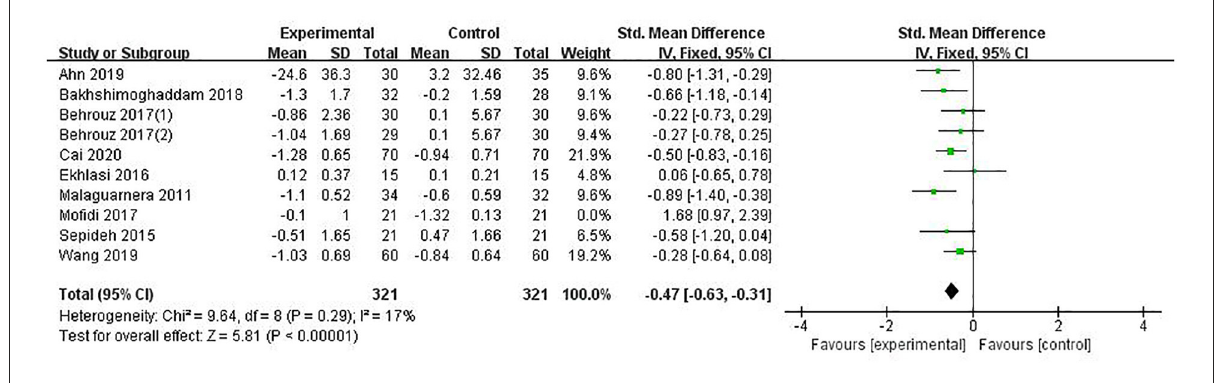
FIGURE4 The role of PPS in HOMA-IR in patients with NAFLD.